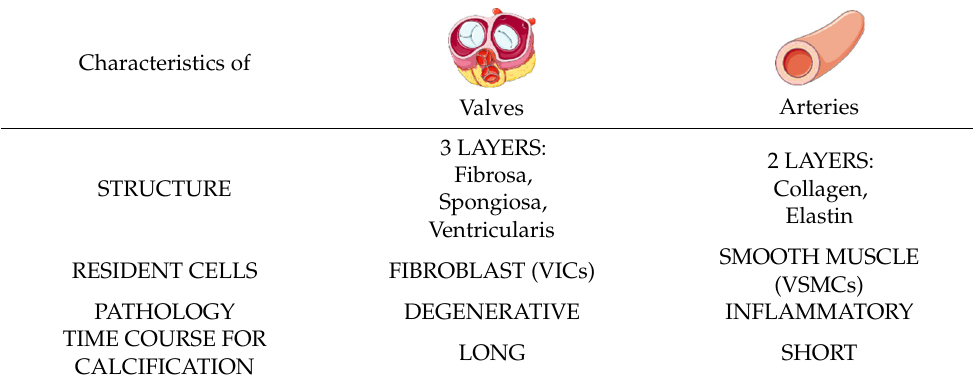
Table 1. Main differences between valvular and vascular tissues.